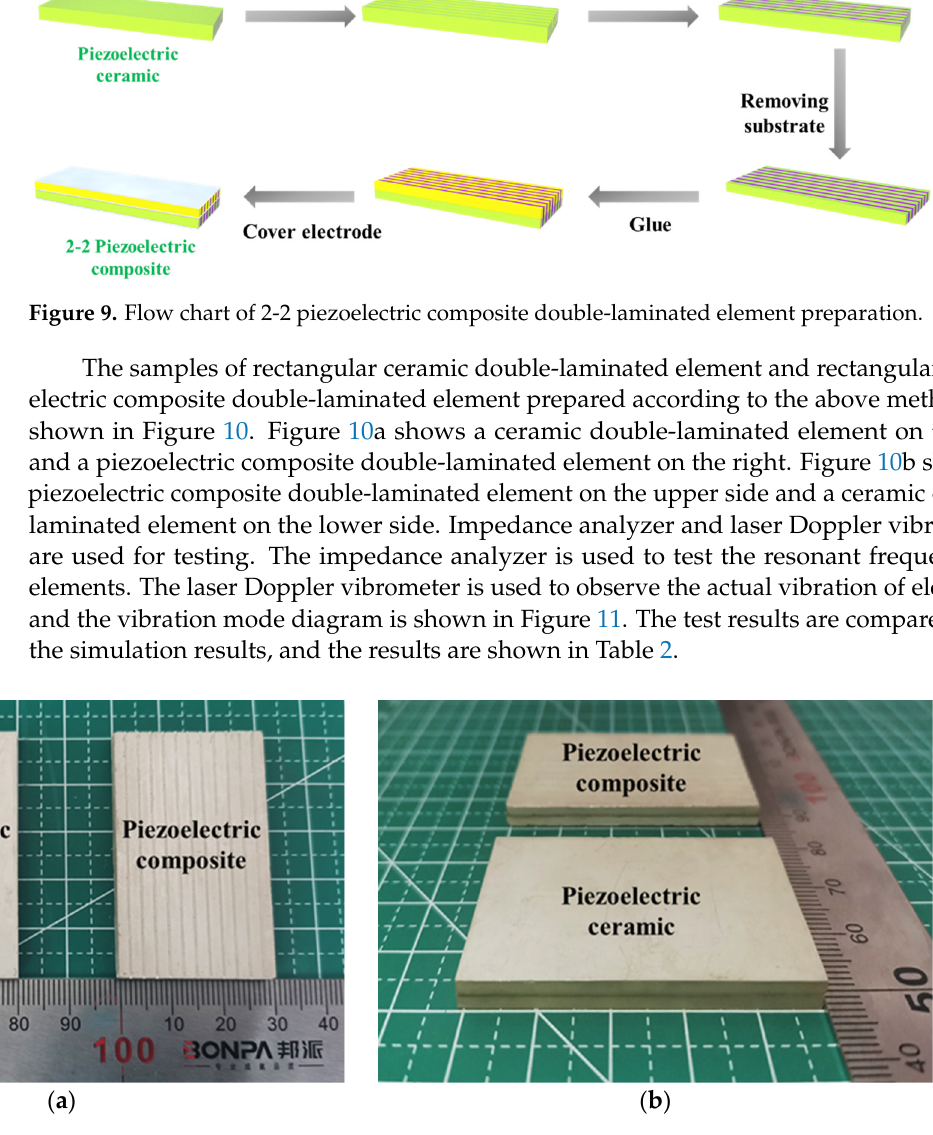
Figure 10. The physical picture of double-laminated elements. ( a ) vertical view; ( b ) side view.